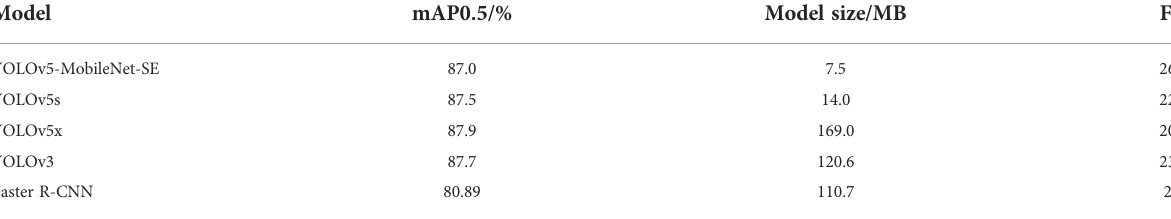
TABLE 2 Comparison of detection results of different models.